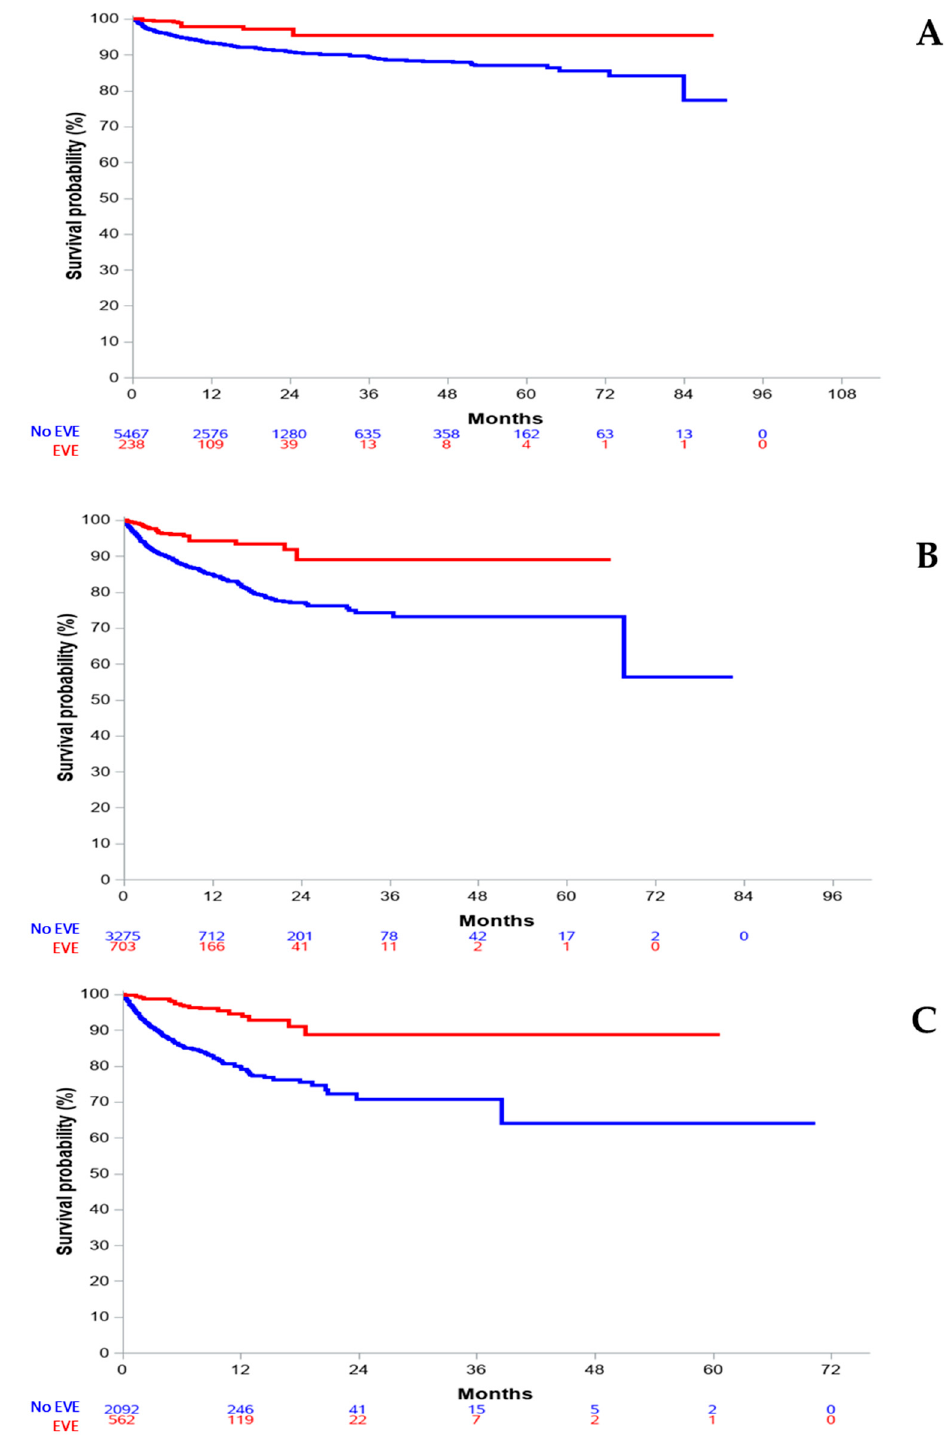
Figure 4. IPTW-adjusted overall survival, according to line of treatment with everolimus. ( A ) first line; ( B ) second line; ( C ) third line and beyond.